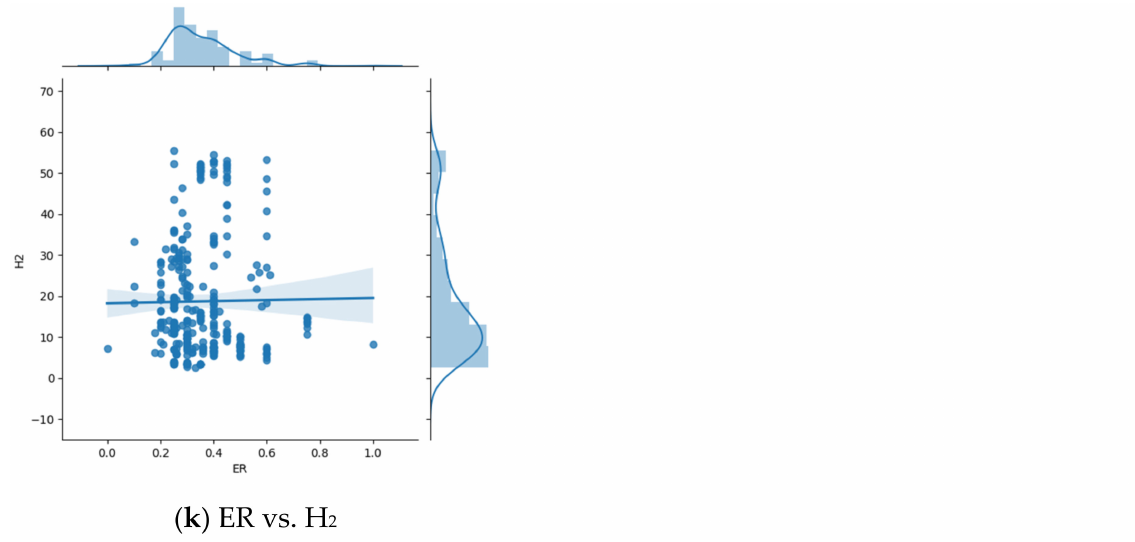
Figure 2. Statistical analyses between the model input features and the